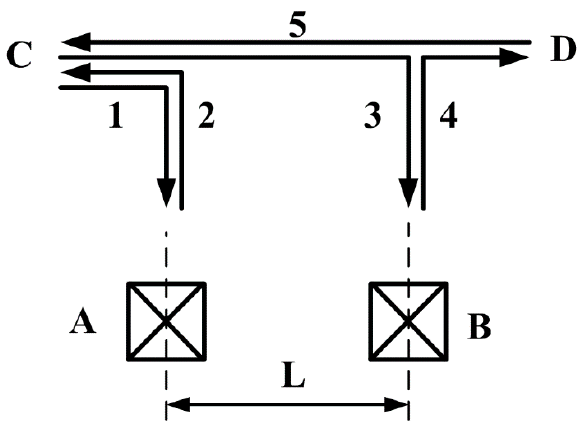
Figure 2. Operation roadmap of a forklift.